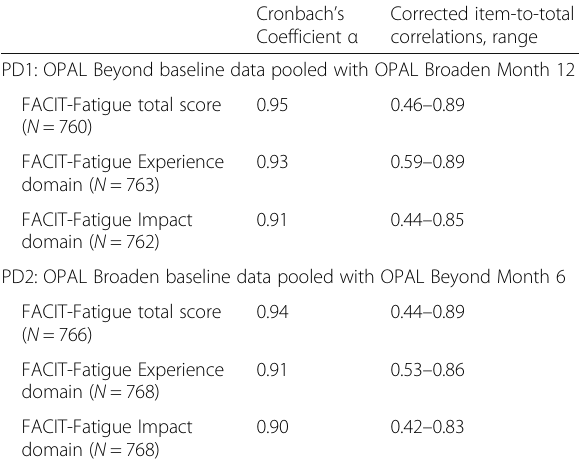
Table 2 Internal consistency reliability of FACIT-Fatigue in patients with PsA